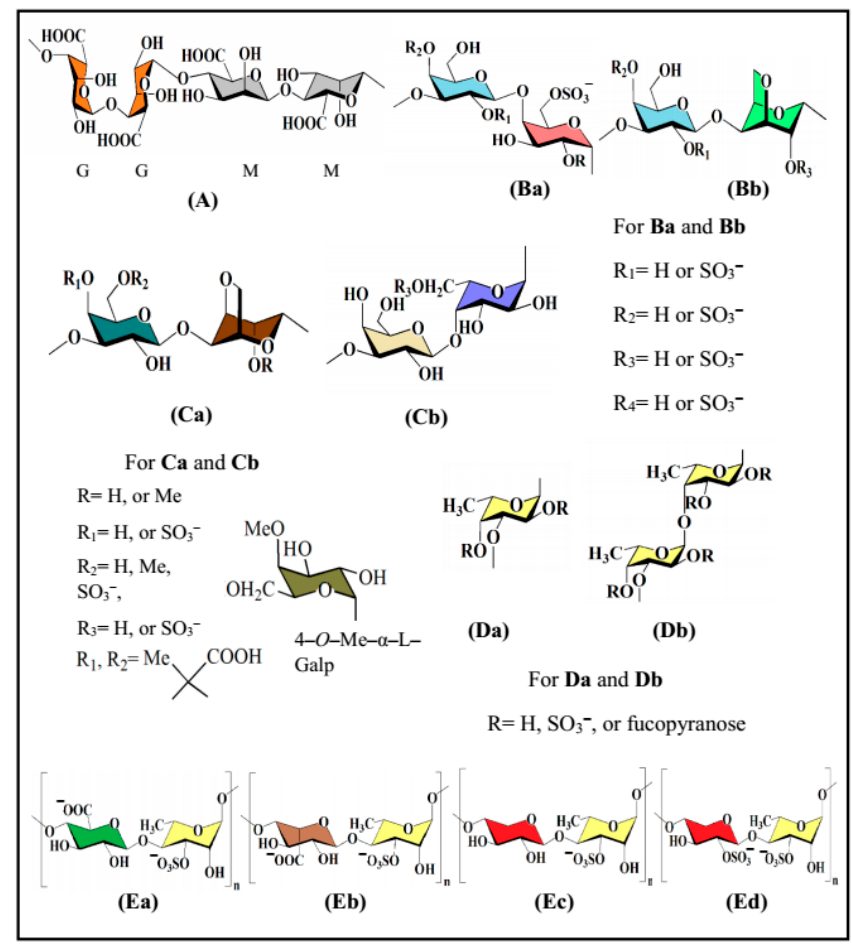
Figure 1. Structures of seaweed ‐ derived polysaccharides possessing in vitro antiviral activity: alginic acid ( A ), carrageenan ( Ba , Bb ), agar ( Ca , Cb ), fucoidan ( Da , Db ) and ulvan ( Ea ‒ Ed ).